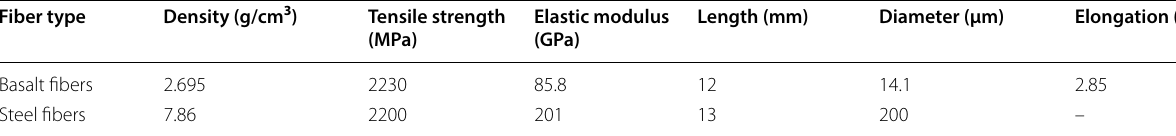
Table 2 Physical and mechanical properties of basalt and steel fibers.